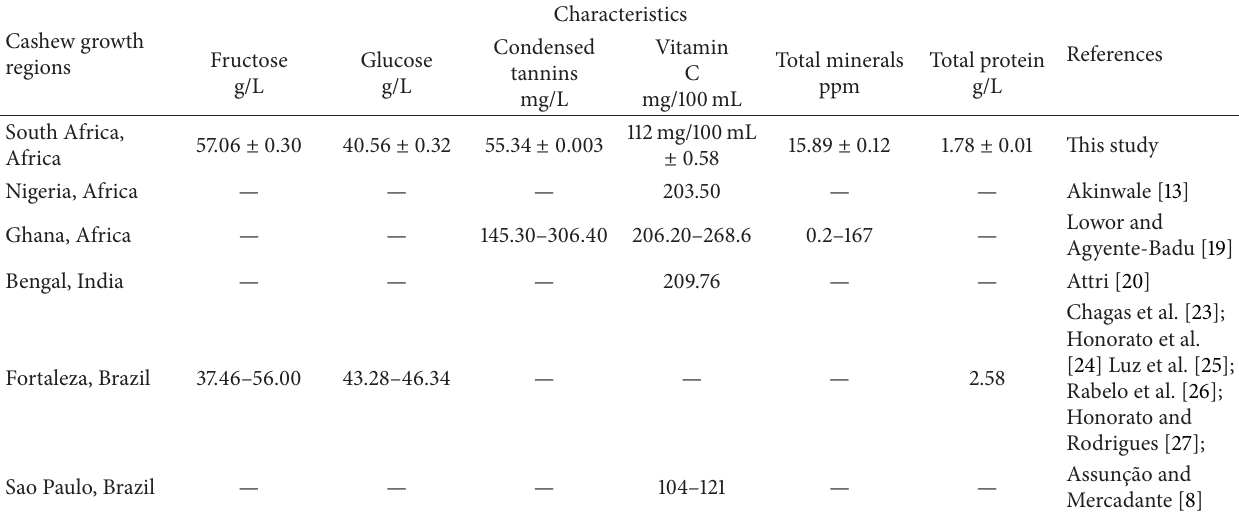
Table 3: Chemical compositional characteristics of cashew apple